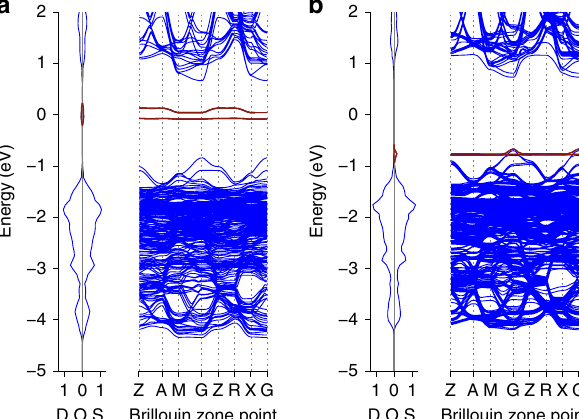
Figure 7 | Band structure and density of states for oxygen incorporation into CH 3 NH 3 PbI 3 . ( a ) O 2 in defect-free CH 3 NH 3 PbI 3 and ( b ) O 2 at iodide vacancy in CH